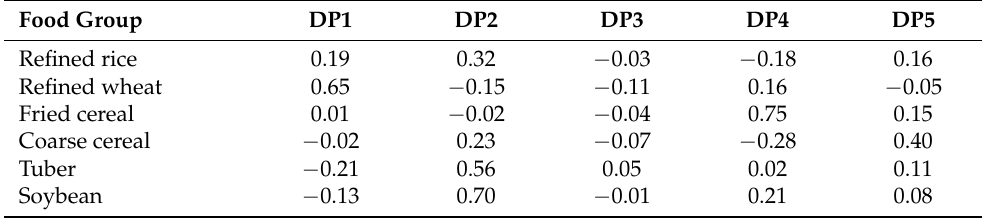
Table 4. Matrix factor loadings of all the food groups in the identified dietary